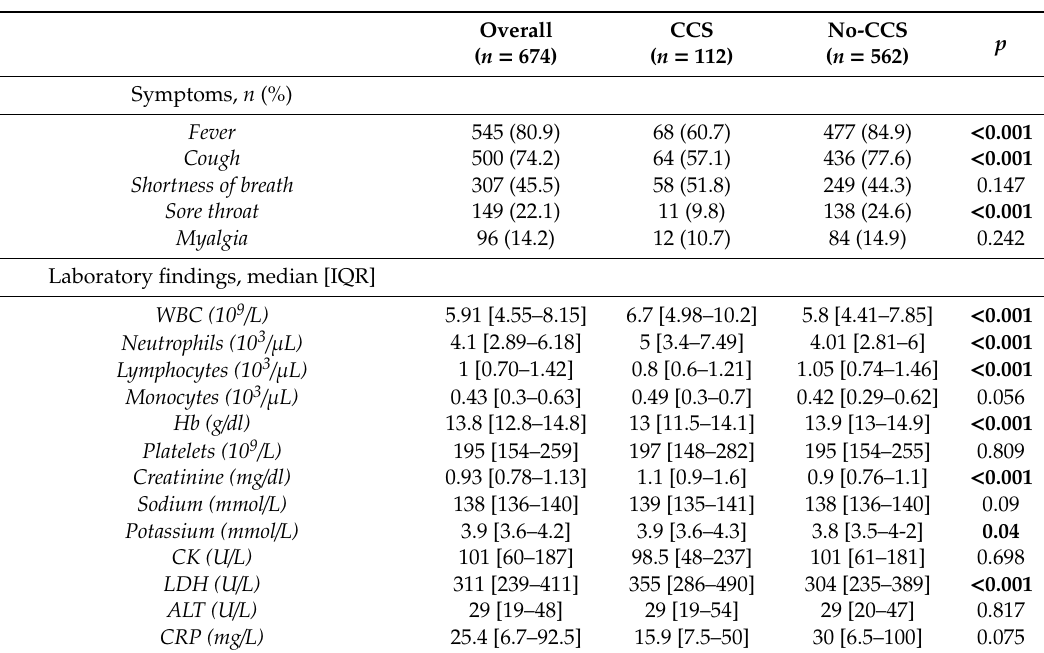
Table 2. Characteristics on